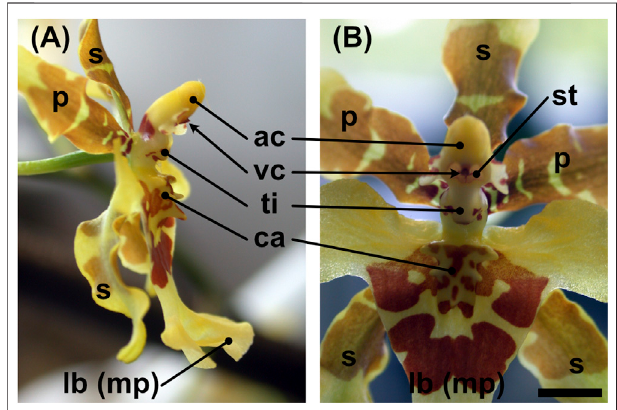
FIGURE 1 | Flower of Oncidium wentworthianum in (A) lateral view and (B) frontal view. ac (cid:1) anther cap, ca (cid:1) callus, lb (mp) (cid:1) labellum (modi fi ed petal), p (cid:1) petal, s (cid:1) sepal, st (cid:1) (fertile part of the) stigma, ti (cid:1) tabula infrastigmatica , vc (cid:1) viscidium. Scale bar: ca. 4